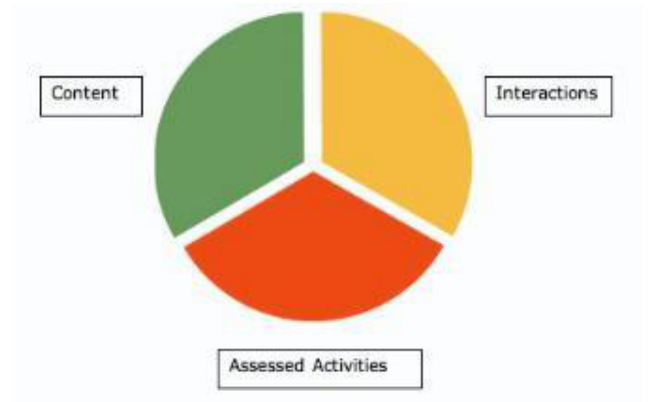
Figure 1 . General course